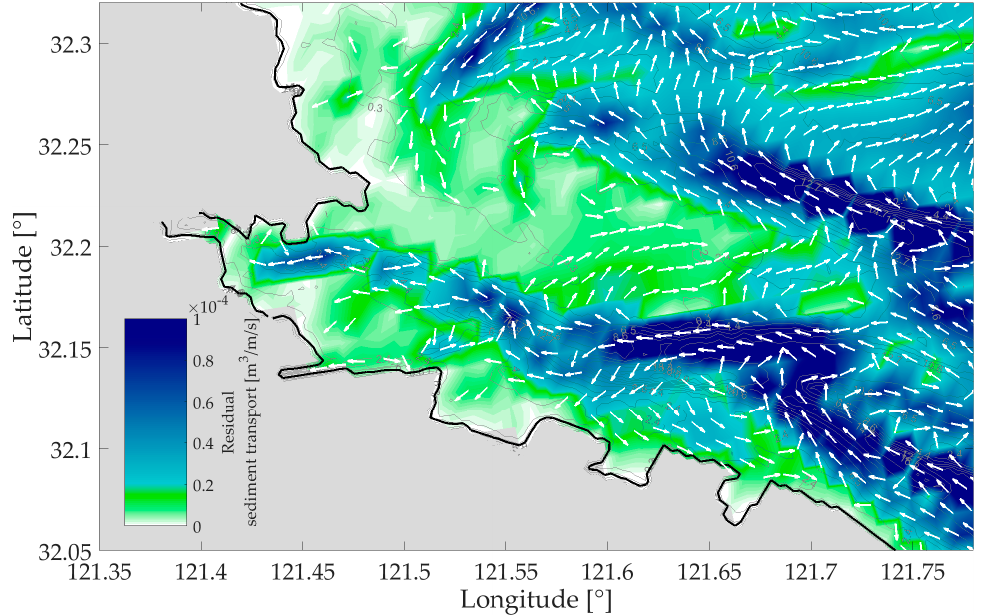
Figure 6. Calculated mean total sediment transport at Yaosha for four consecutive spring-neap cycles.